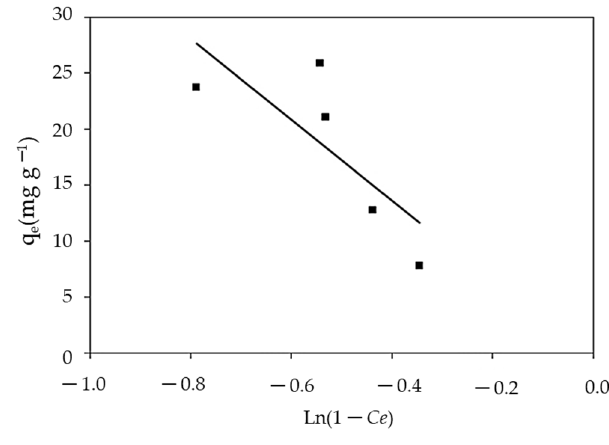
Figure 16. Smith isotherm for MBD sorption.